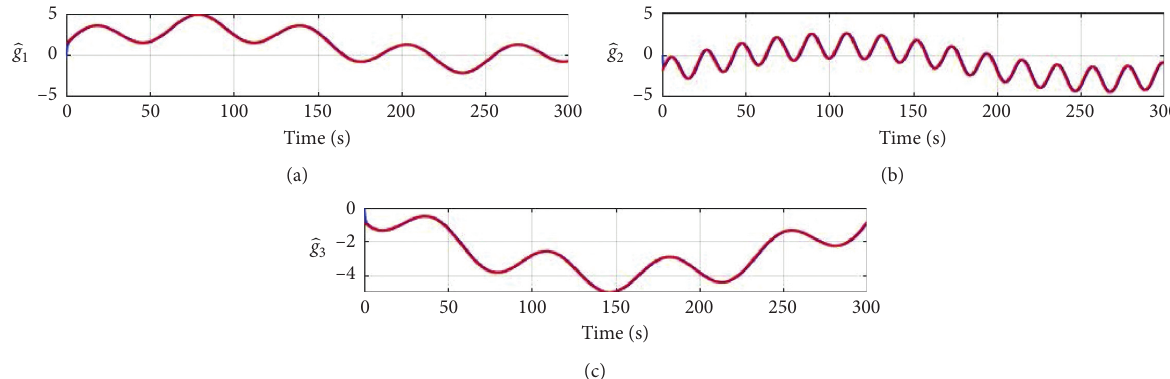
, g , and g and their estimations 􏽢 g 1 2 3